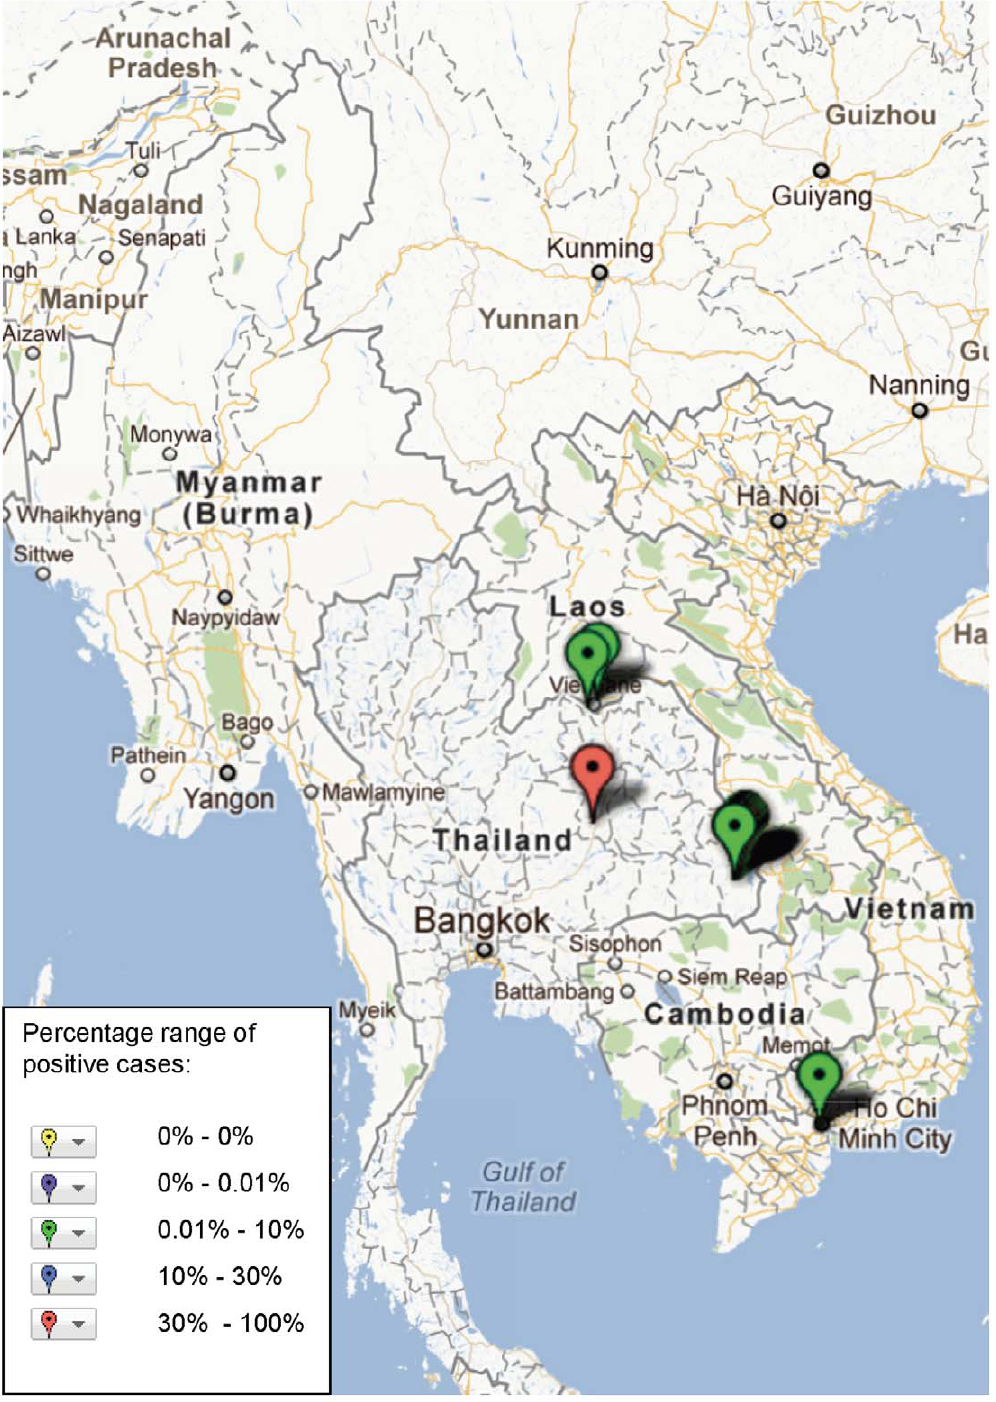
Figure 5. Study sites in the Mekong region where B.pseudomallei has been reported, illustrating frequency of identification (case) based on assays and sample population used in the study (see Table